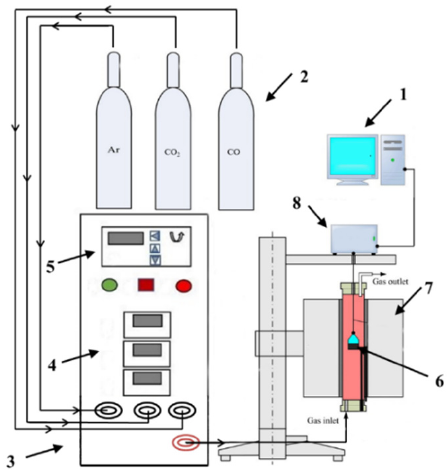
Figure 4. Schematic diagram of the apparatus for thermogravimetric experiment of pellets. 1—computer; 2—gas cylinder; 3—controller; 4—gas flow control interface; 5—temperature control interface; 6—pellet sample; 7—vertical furnace heating furnace body; 8—electronic balance.